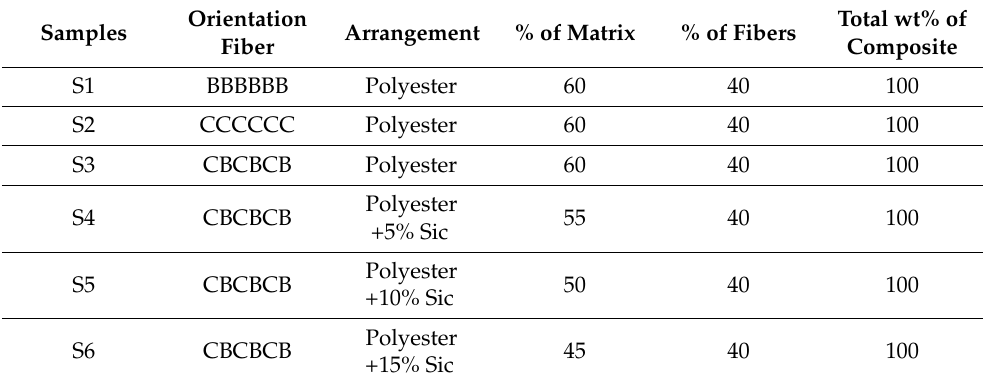
Table 2. Composition specimen